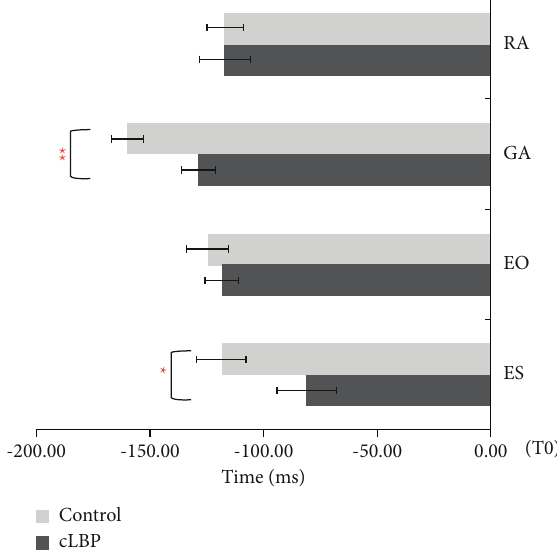
Figure 5: The muscle onset time between the cNLBP and control groups in the external perturbation task. RA, rectus abdominis; GA, gastrocnemius; EO, lateral external oblique; ES, erector spine. ∗ p < 0 . 05; ∗∗ p < 0 . 01 .